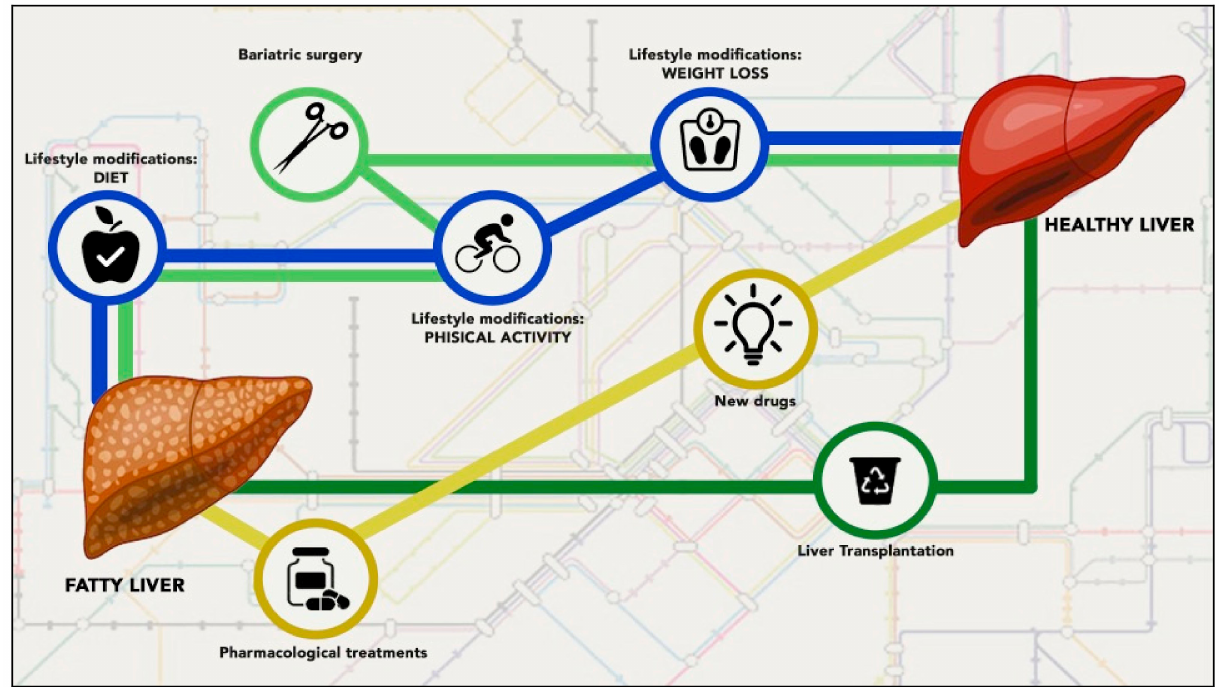
Figure 1. Current proposed treatments for non-alcoholic fatty liver disease (NAFLD) and its advanced forms. Although specific therapies for NAFLD are not approved yet, general strategies have been proposed to manage it, including: (a) lifestyle change (blue line), (b) glucose-lowering agents (including pioglitazone), or antioxidants (such as vitamin E), or other promising drugs (yellow line), (c) bariatric surgery in patients with severe obesity (i.e., BMI > 35 kg/m 2 ) (light green line), and (d) liver transplantation in selected cases (dark green